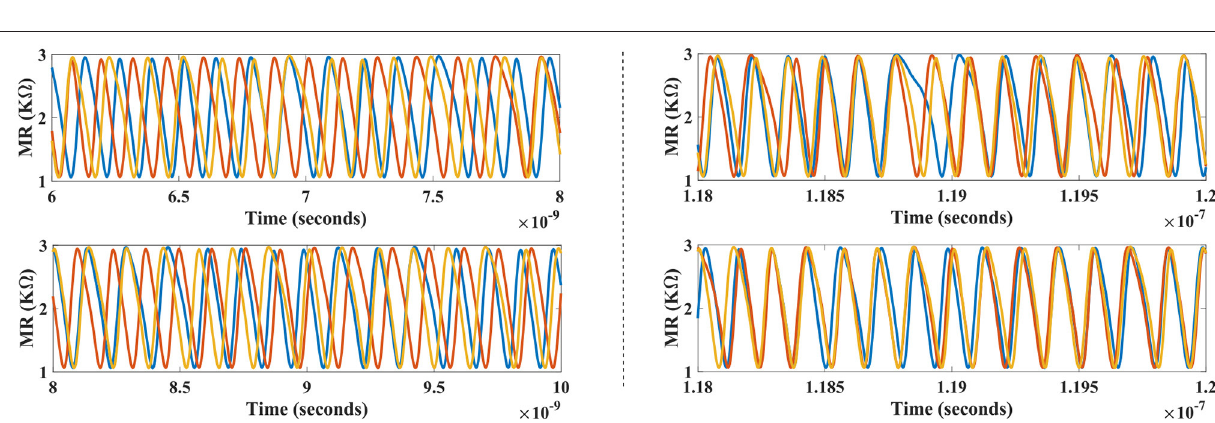
FIGURE 8 | Temporal profile for the devices in the network (shown in Figure 5B ) before (left) and after synchronization (right) are depicted for one particular configuration. Astrocyte functionality activates the synchronous regime causing learning to occur and subsequently coherent neural patterns are achieved for this configuration (a stochastic event). Devices N 1 , N 2 , and N a (top-right panel) lock to injection signal with φ = 0 ◦ , while devices N 3 , N 4 , and N b reveal concerted neural patterns in conjunction to φ = 180 ◦ injection signal (bottom-right